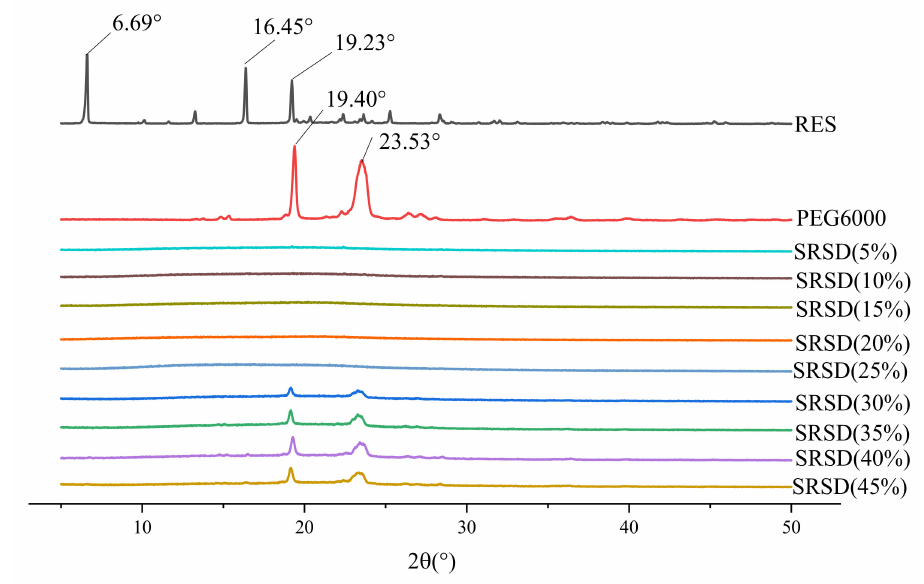
Figure 6. XRD diagram of solid dispersion prepared by different amount of release modifier.